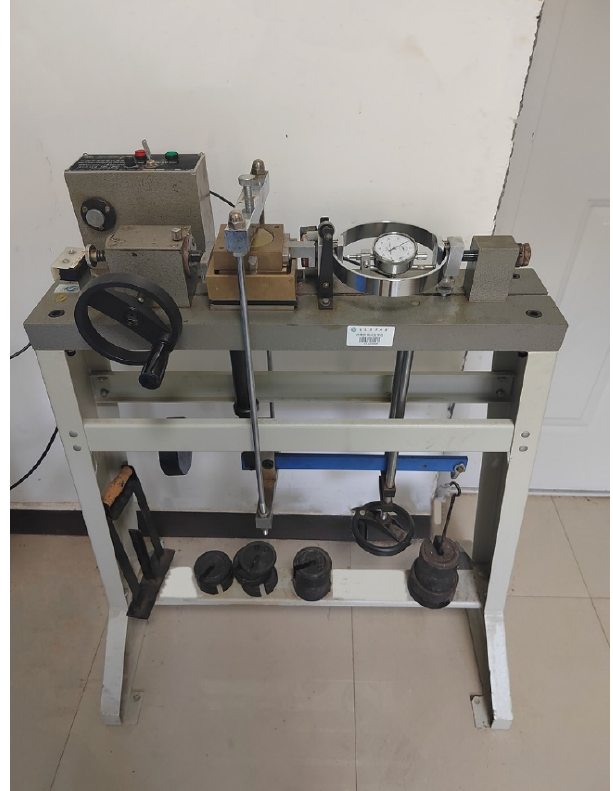
Figure 16. ZJ strain-controlled direct shear apparatus. Table 6. Results of the direct shear tests for different varieties of Cyperus esculentus seeds.